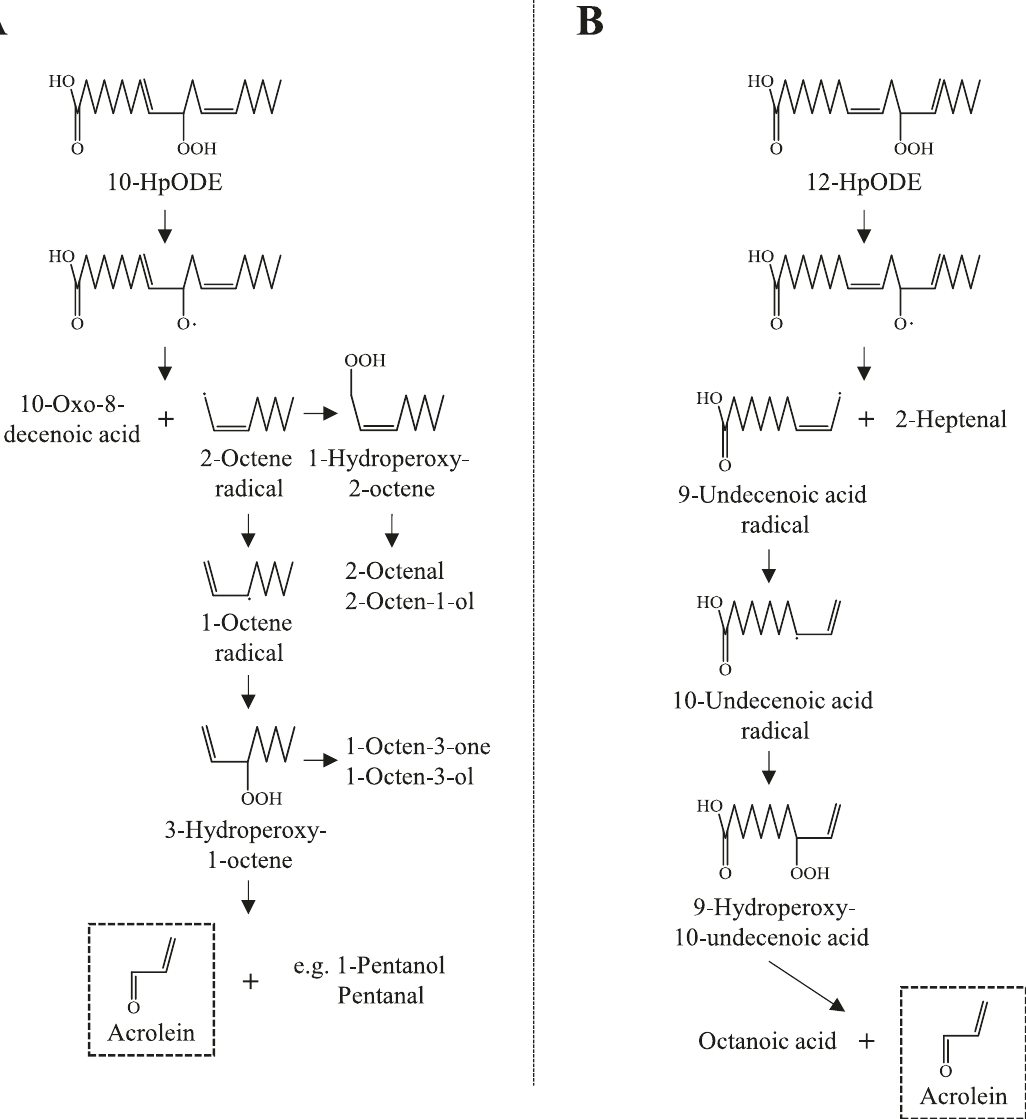
Fig. 4 Proposed pathways leading to the generation of acrolein. 10-HpODE ( A ) and 12-HpODE ( B